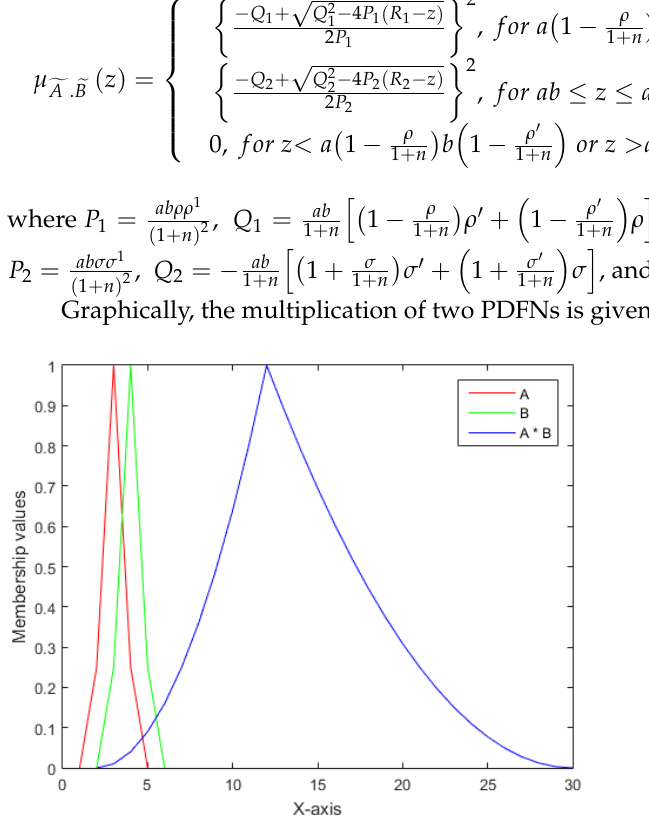
Figure 6. Multiplication of two parabolic dense fuzzy numbers